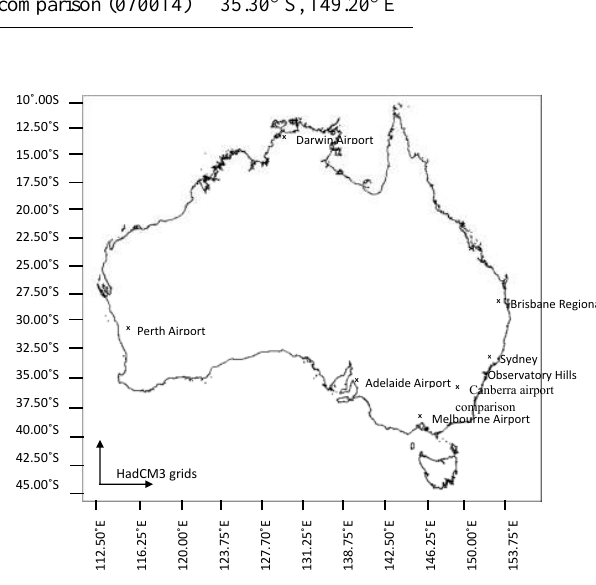
Figure 1. Location map of study